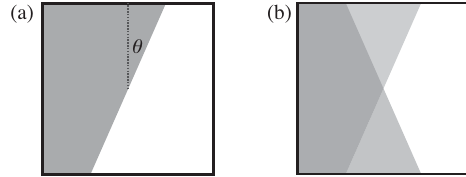
FIG. 5. (a) A nonequilibrium distribution p θ that is “ rotated ” by an arbitrary angle θ [Eq. (49)]. (b) The distribution in (a) under the action of the vertical reflection twirling operator ϕ G ð p θ Þ .